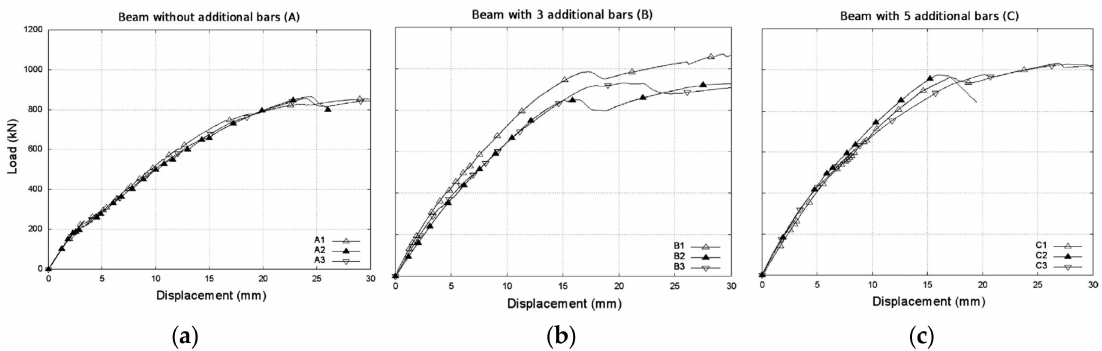
Figure 17. Load-displacement curves: ( a ) beams without lower rebars; ( b ) beams with three added lower rebars; ( c ) beams with five lower added rebars (Amadio et al.